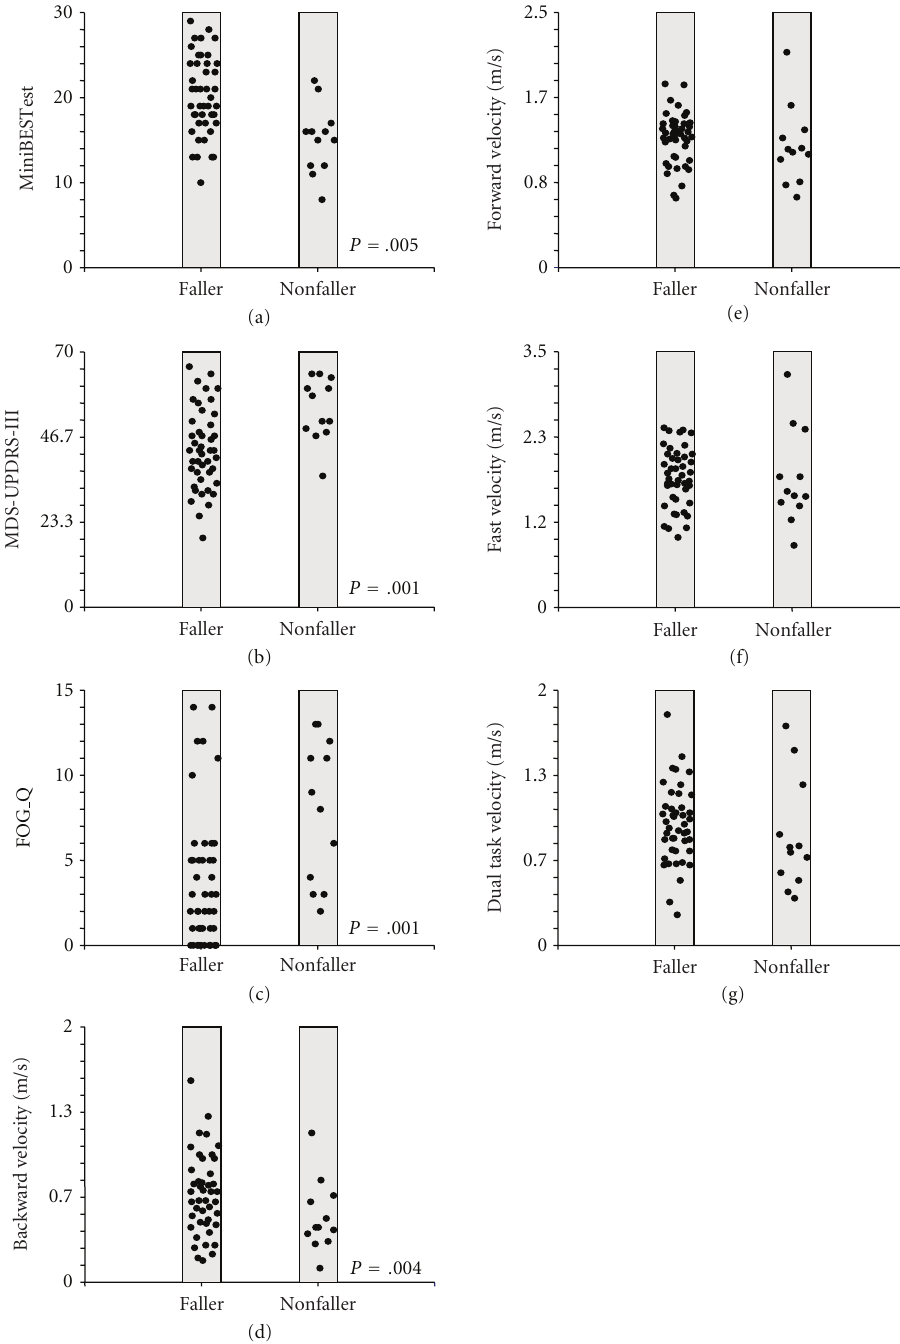
Figure 1: Dot plots for the nonfaller and faller groups for Mini-BESTest (a), MDS-UPDRS-III (b), FOGQ (c), backward walking velocity (d), forward walking velocity (e), fast walking velocity (f), and dual task walking velocity (g). Items in the left column are those that were significantly di ff erent between nonfallers and